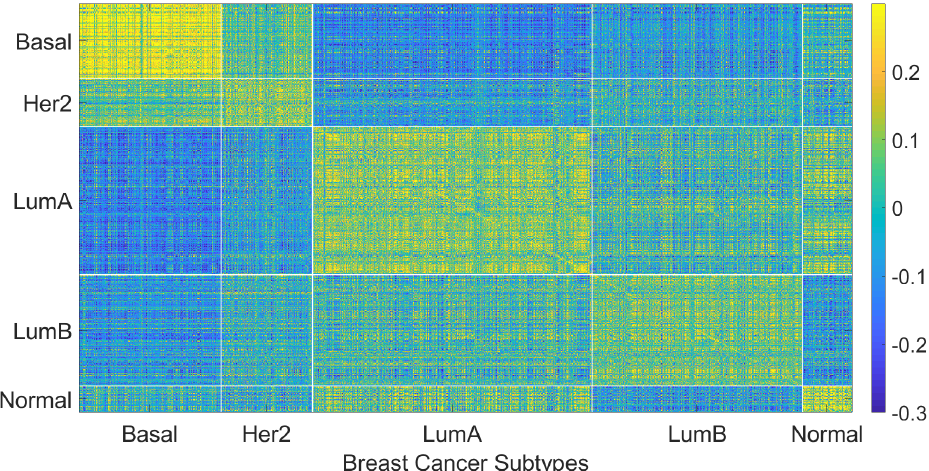
Figure 4. Patient to patient Pearson correlation coefficient of gene expression organized by breast cancer intrinsic subtypes.